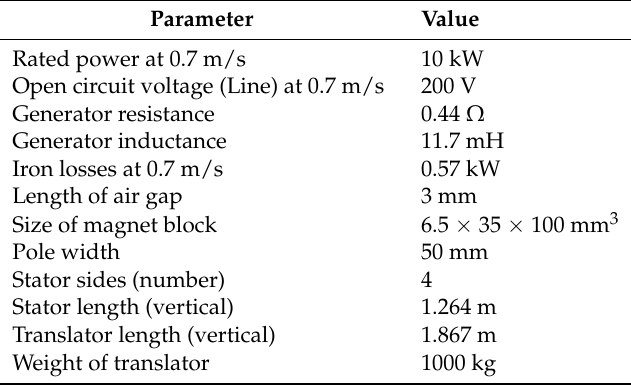
Table 1. Linear-generator specifications